Question: Compose a caption that would accompany this figure in a paper.
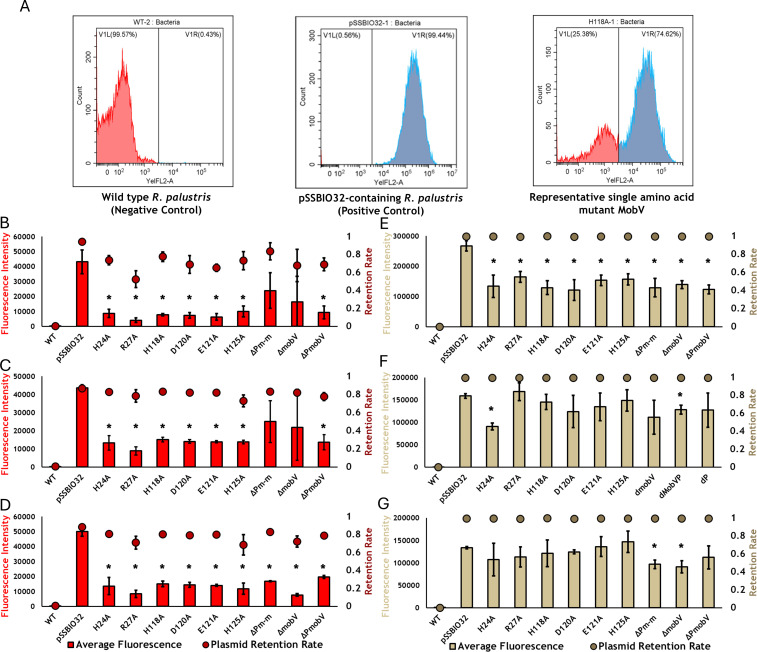
Answer: ( A ) Flow cytometry histograms for mRFP fluorescence on each MobV mutant pSSBIO32 plasmid. Left: Example of a wild-type R. palustris culture without an mrfp fluorescent tag, serving as a negative control. Middle: Example of a transformed R. palustris culture with pSSBIO32 containing an unmodified mobV gene, serving as a positive control. Right: Example of a transformed culture with a pSSBIO32 plasmid with a mutation to mobV . ( B–D ) Flow cytometry results for R. palustris cultures after ( B ) 4 days, ( C ) 8 days, and ( D ) 12 days of incubation. ( E–G ) Flow cytometry results for E. coli cultures after ( E ) 1 day, ( F ) 2 days, and ( G ) 3 days of incubation. Bars represent the whole culture average fluorescence intensity (left axis), and circles represent corresponding plasmid retention rates (right axis) for n = 3. Error bars for both fluorescence and plasmid retention represent one standard deviation. Asterisks represent significant differences in fluorescence intensity between the individual mutants and the positive control vector, pSSBIO32. Plasmid retention rates were consistent to the point where they are not easily visible, and standard deviations can be instead found in Table S1 . P values for determining significant differences according to Welch’s t -test for n = 3 can also be found in Table 1 .